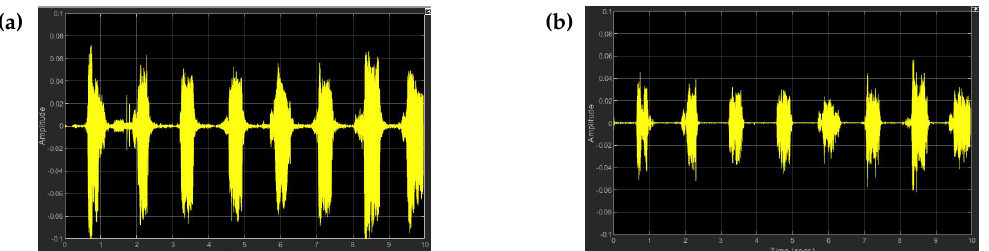
Figure 2. Noise and background speech removal from the recorded audio samples. ( a ) Time- waveform of the noisy audio samples. ( b ) Time-waveform of the clean audio samples.